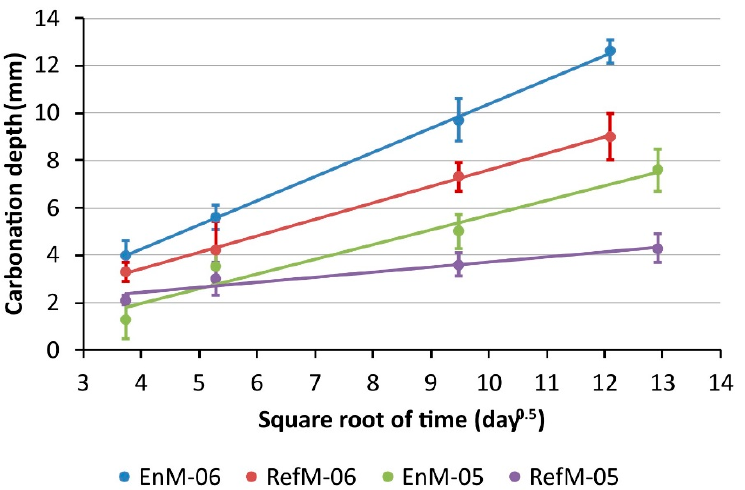
Figure 4. Carbonation depth, measured visually after spraying the split samples with a pH indicator, plotted against the square root of time. “EnM” and “RefM” stand for EnDurCrete and the reference mortar respectively, while the extensions “-06” and “-05” refer to water/cement ratios of 0.6 and 0.5. The error bars indicate the variation in the carbonation depth - measured in 10 pointson one sample for each mortar and exposure time. Table 4. Results of regression analysis based on the measured values of carbonation depth at four different time intervals. As per (Equation (1)), parameter K AC is the carbonation rate and parameter a is a constant representing the y-axis intercept, while R 2 is the coefficient of determination indicating the quality of fit. “EnM” and “RefM” stand for EnDurCrete and the reference mortar respectively, while the extensions “-06” and “-05” refer to water/cement ratios of 0.6 and 0.5. Parameter EnM-06 RefM-06 EnM-05 RefM-05 K AC (mm day − 0.5 ) 1.03